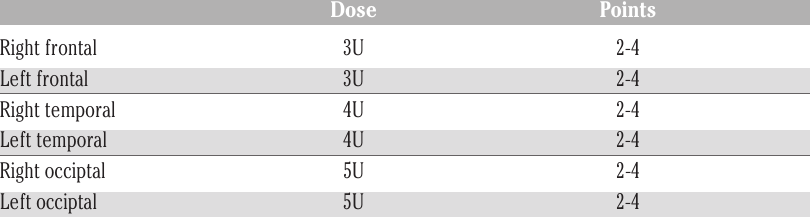
Table 1. Allodynic sites and total injected in each point.